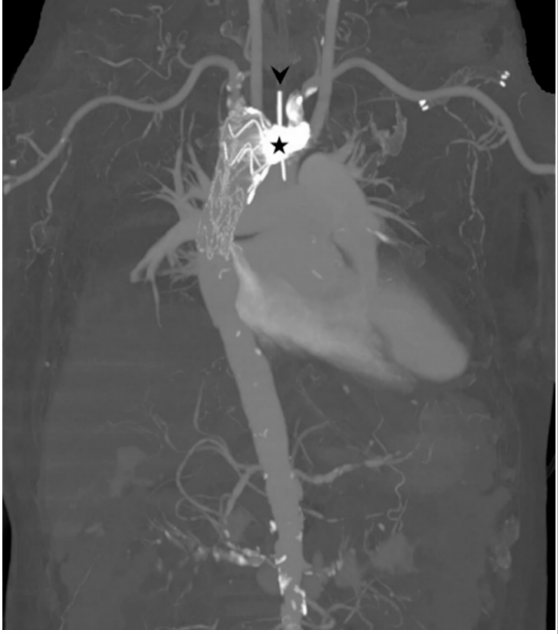
Figure 6. Maximum-intensity-projection image showing the result of the thoracic endovascular aortic repair and left subclavian artery coiling (star). An arrowhead indicates the nasogastric tube in the